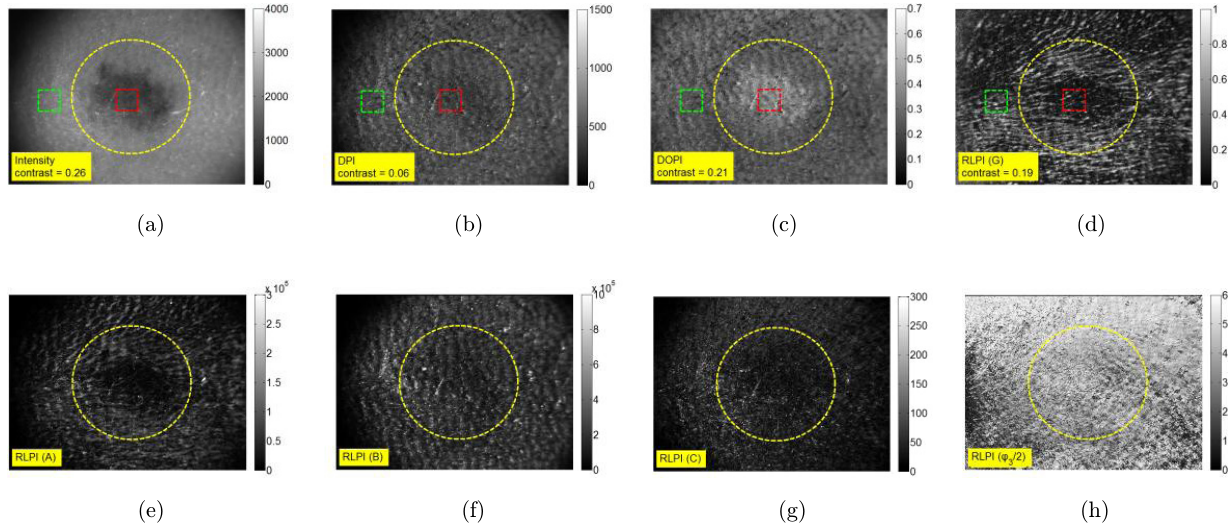
Fig. 2. Experimental results of sample 1: (a) intensity, (b) DP, (c) DOP, (d) G , (e) A , (f) B , (g) C and (h) ’ 3 = 2, for a nude mouse's melanoma with carcinoma B16. The carcinoma areas are marked by yellow circles. Contrast between the healthy (marked as green squares) and cancerous skin tissues (marked as red squares) for intensity, DP, DOP and G are: 0.26, 0.06, 0.21 and